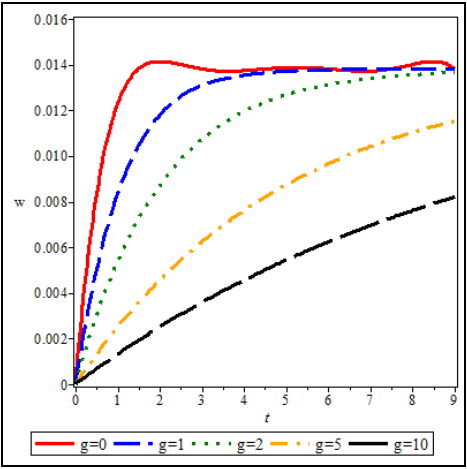
Figure 7. Viscoelastic effects on the results.